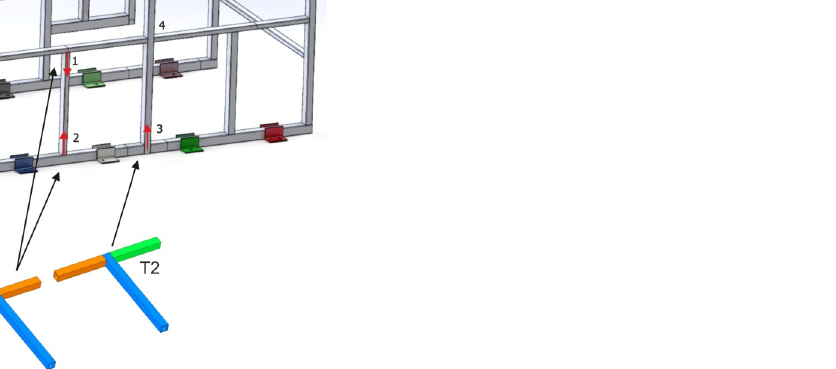
Figure 13. Equivalence of the complex structure joints to the T1 and T2 junctions.